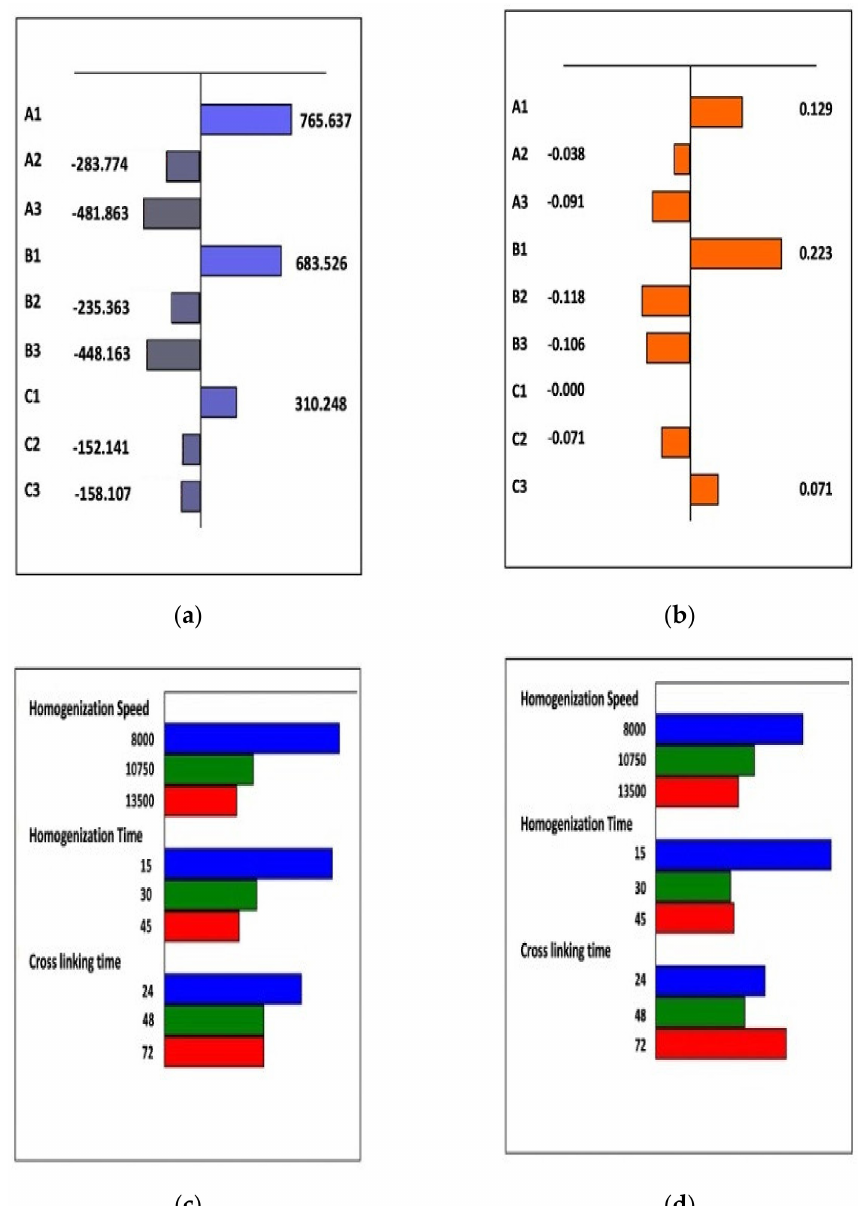
Figure 2. Graph mode representation of partial and total effects associated with the factor levels for: ( a , c ) the nanoparticle size; ( b , d ) polydispersity index (PDI) of NanoC. Effect estimations were obtained after NEMROD analysis by using the least square methods. The factor effect levels are expressed in coded values as reported in Table